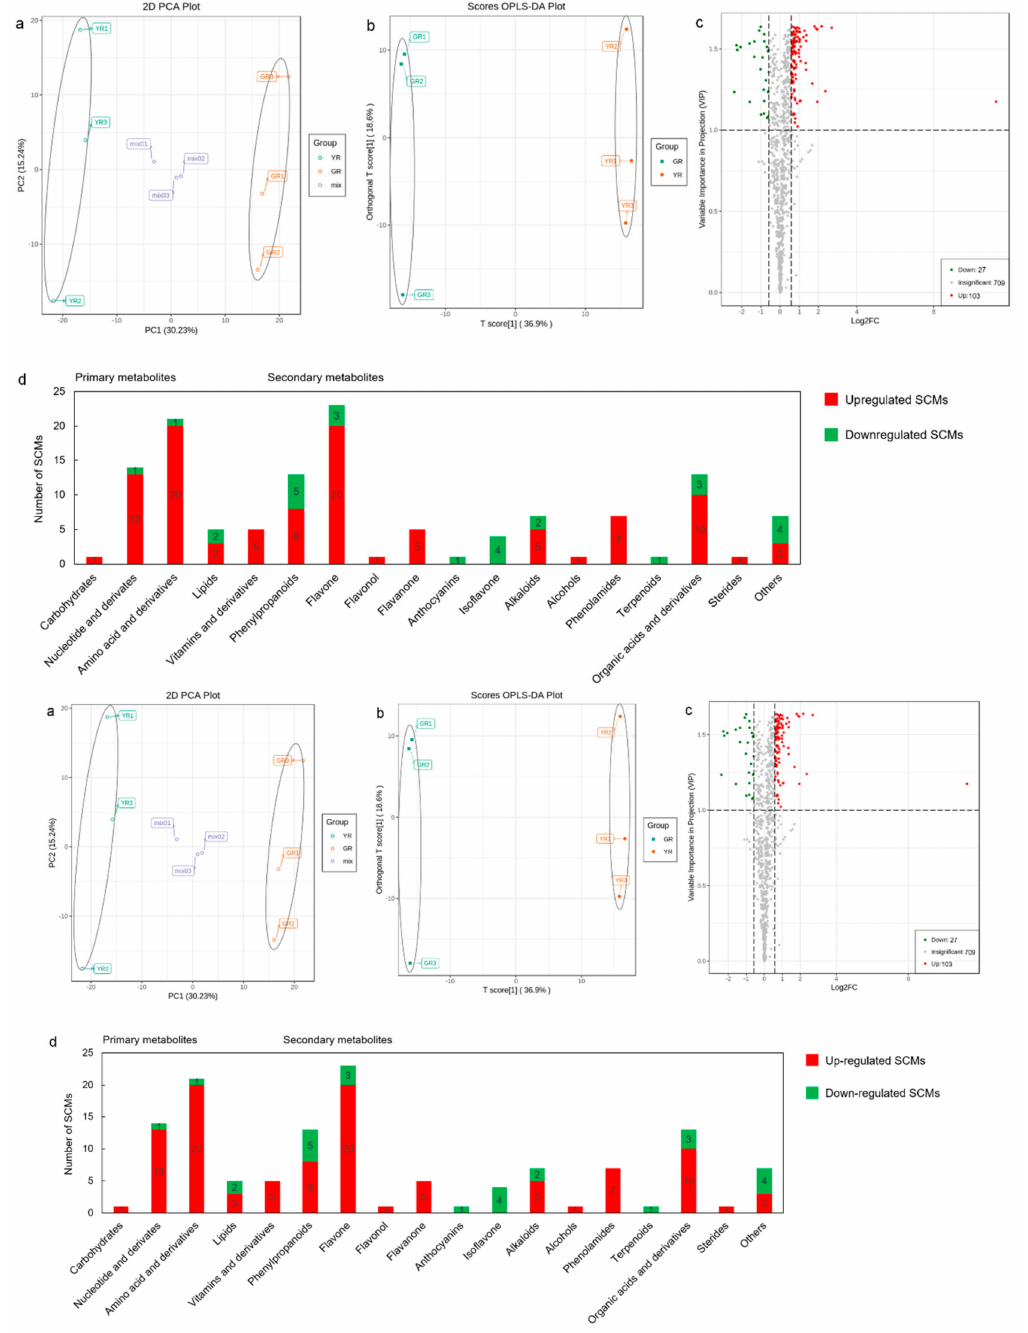
Figure 2. Multivariate statistical analysis of metabolites from YR and GR. ( a ) PCA score plot of metabolites between the young shoots of YR and GR. ( b ) OPLS-DA score plot of metabolites between the young shoots of YR and GR. ( c ) Volcano plot of metabolites between the young shoots of YR and GR. ( d ) The 130 SCMs were divided into 20 categories, of which 103 were